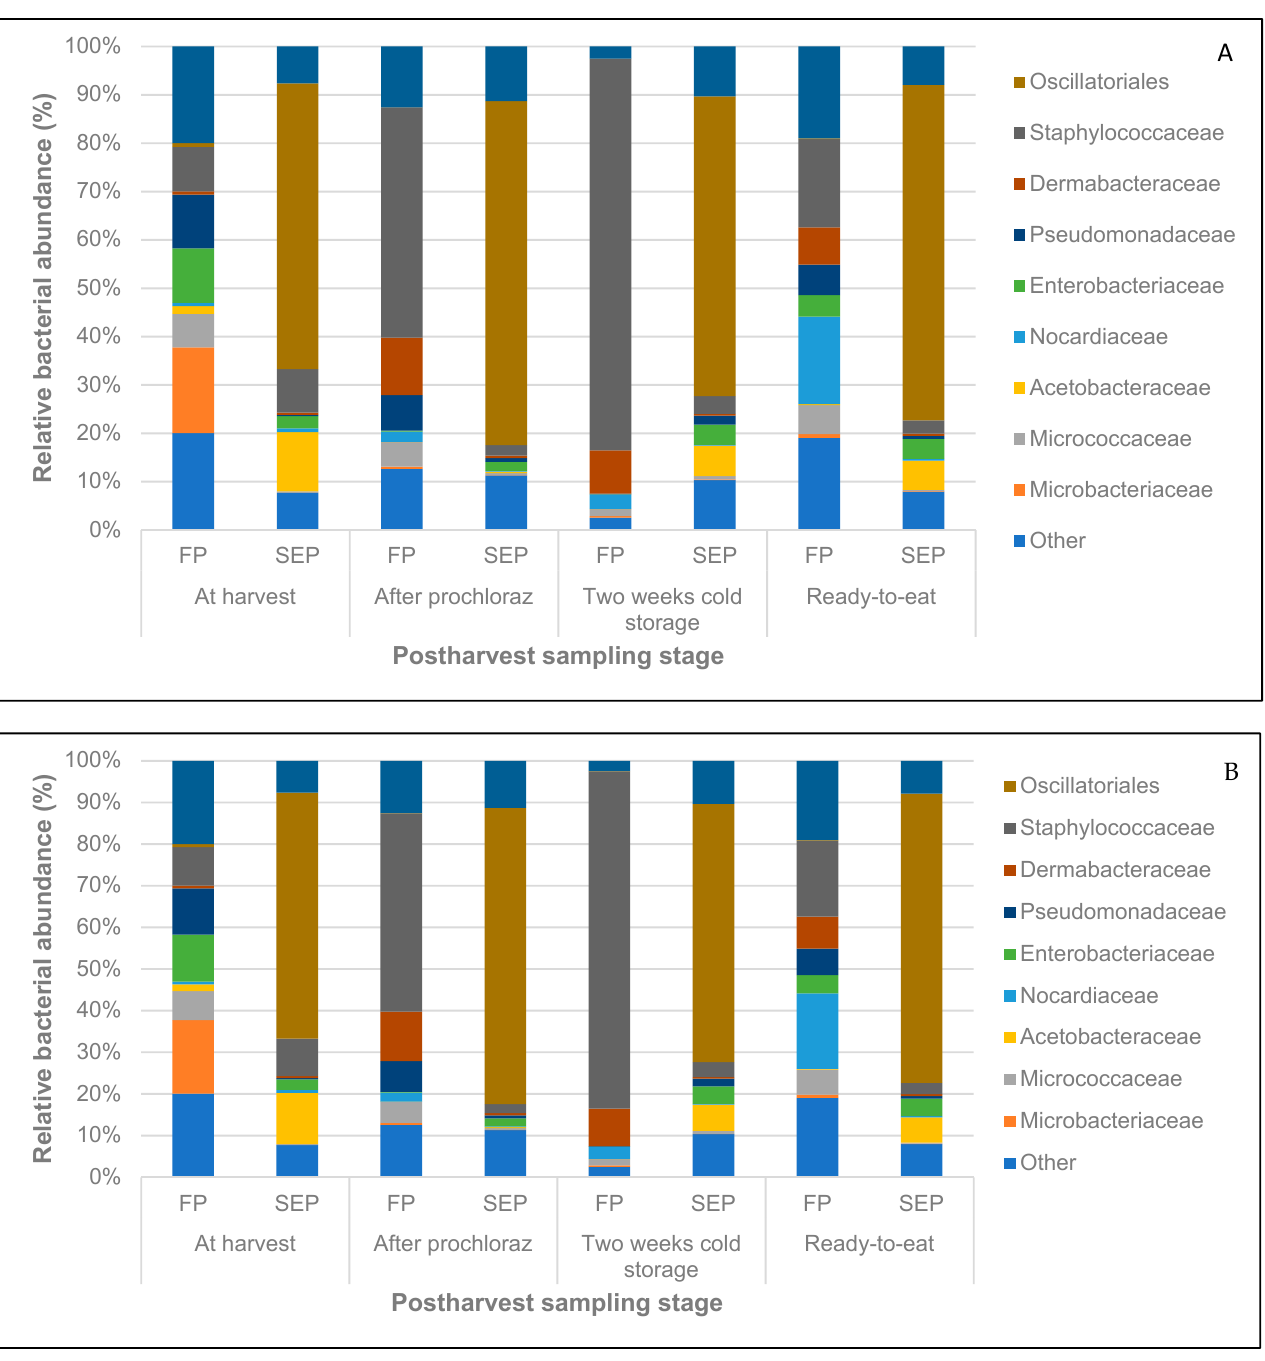
Figure 5. Taxonomic abundance of nine dominant bacterial families on the mango fructoplane, stem-end pulp and fruit stem at the pre-harvest ( A ) and post-harvest ( B ) stages of cv. Tommy Atkins mangoes. FP, fructoplane; SEP, stem-end pulp; S, fruit stem.